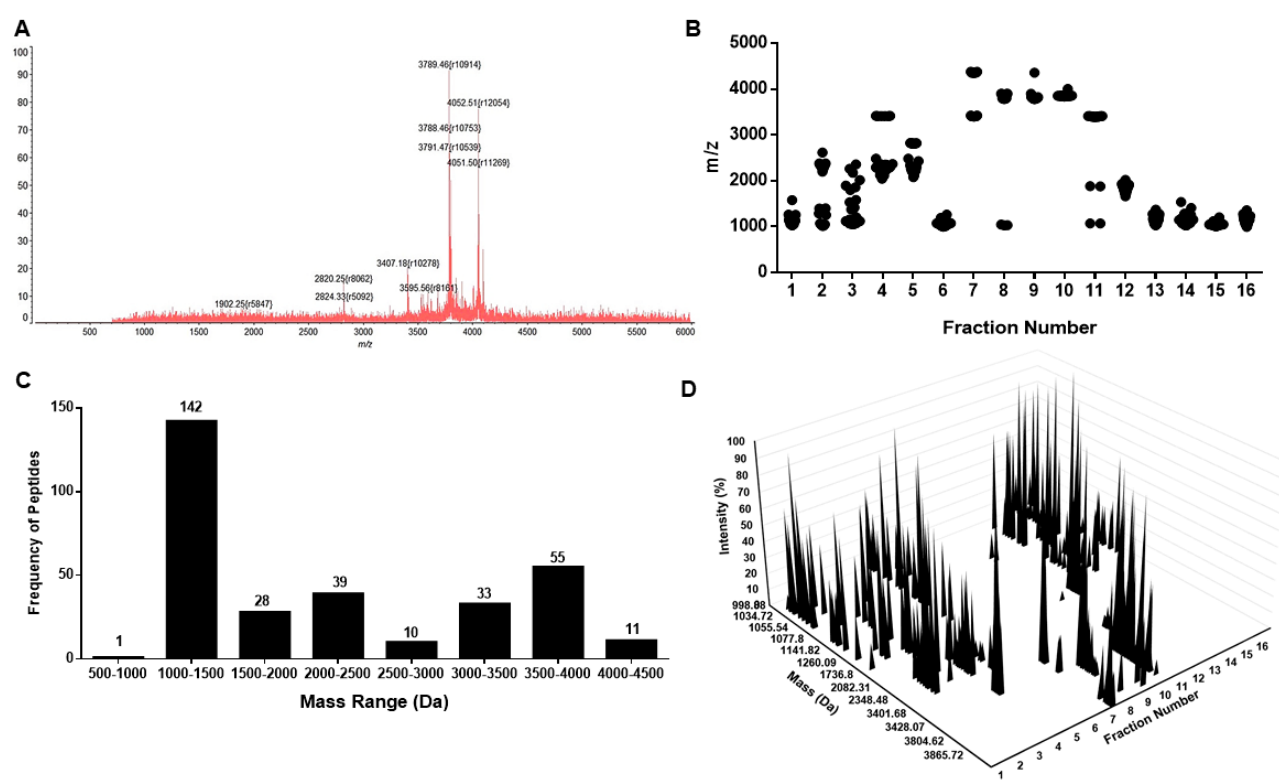
Figure 4. Distribution of peptide masses from Phlogiellus bundokalbo whole venom. (A) MALDI-TOF-MS spectrum of whole spider venom. (B) Distribution of venom peptide fractions as a function of mass-to-charge ratio collected from the RP-HPLC and compared with MALDI-TOF-MS spectra. (C) Histogram peptide frequency distributed and sorted according to 500 Da interval. (C) The 3D venom landscape of Phlogiellus bundokalbo venom is plotted according to the percentage area of peak intensity, mass-to-charge ratio from MALDI-TOF-MS and fraction number from RP-HPLC.